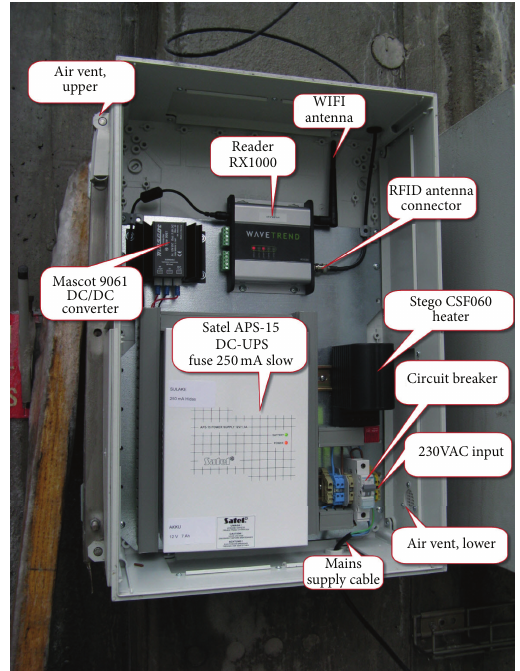
Figure 6: A WLAN-reader.